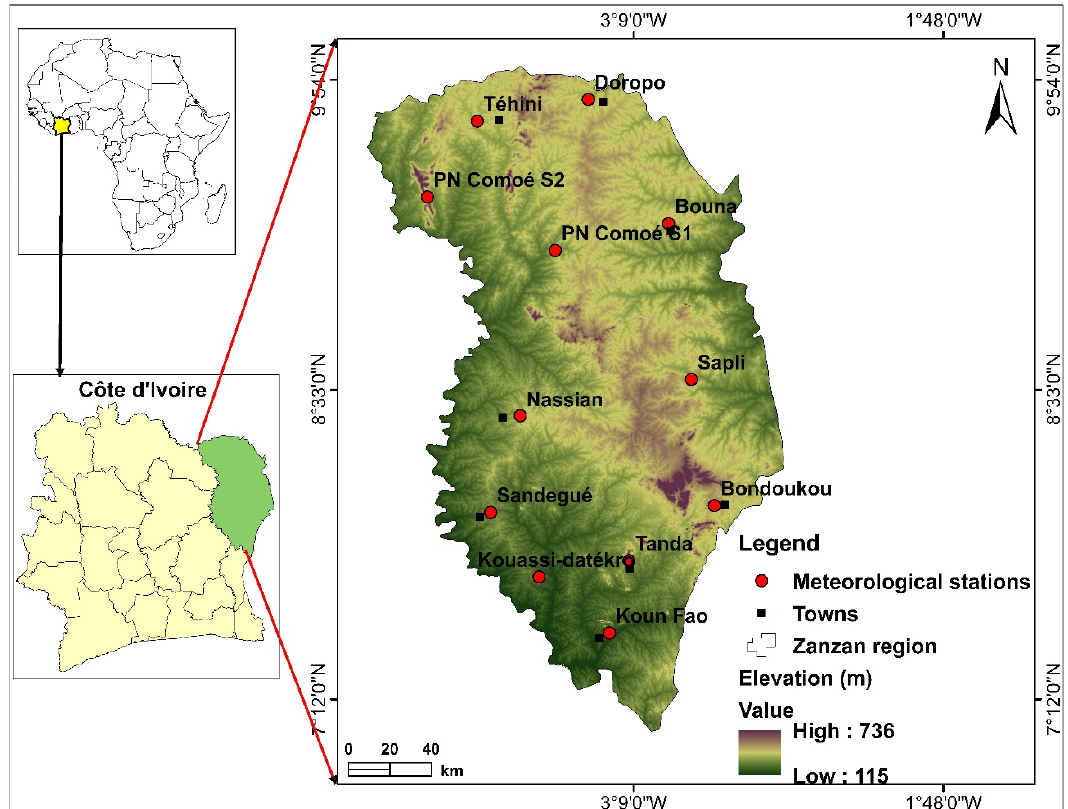
Figure 1. Geographical location of the Zanzan region and spatial representation of the meteorolog- ical stations of the study. stations of the